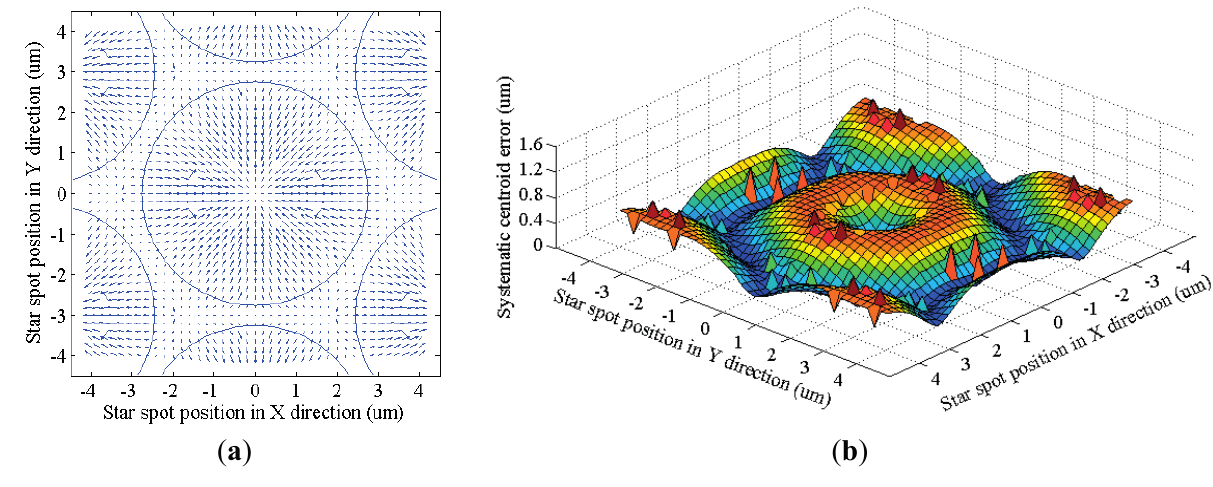
Figure 10. Systematic centroid error of the FOFP. ( a ) Error vector distribution; ( b ) Error magnitude distribution.